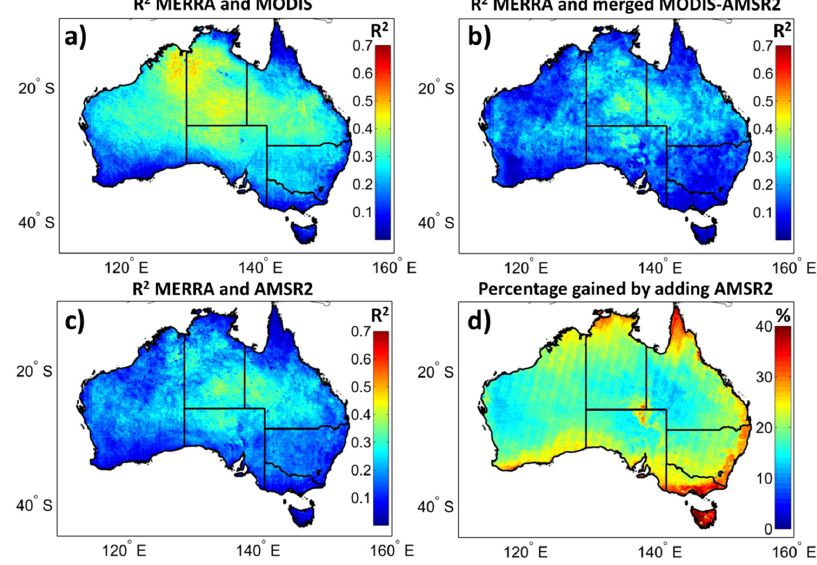
Figure 5. R 2 between the anomalies from MERRA and ( a ) MODIS; ( b ) the merged MODIS-AMSR2 Land Surface Temperature product and ( c ) AMSR2, as well as the percentage of gained samples through the addition of AMSR2 observations ( d